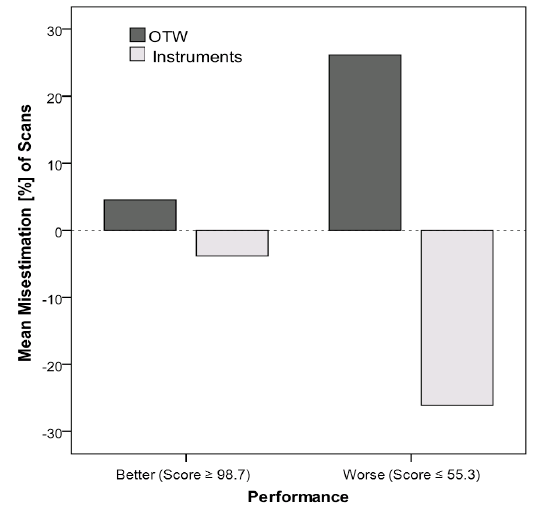
Figure 12. Self-Assessment of Better and Worse